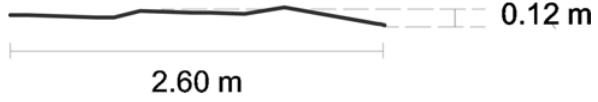
Fig.6: Cross sections extracted along the bands of acquisition with automatic processes